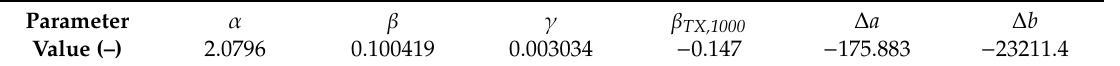
Table A6. SHML constants for the footing settlement calculations.